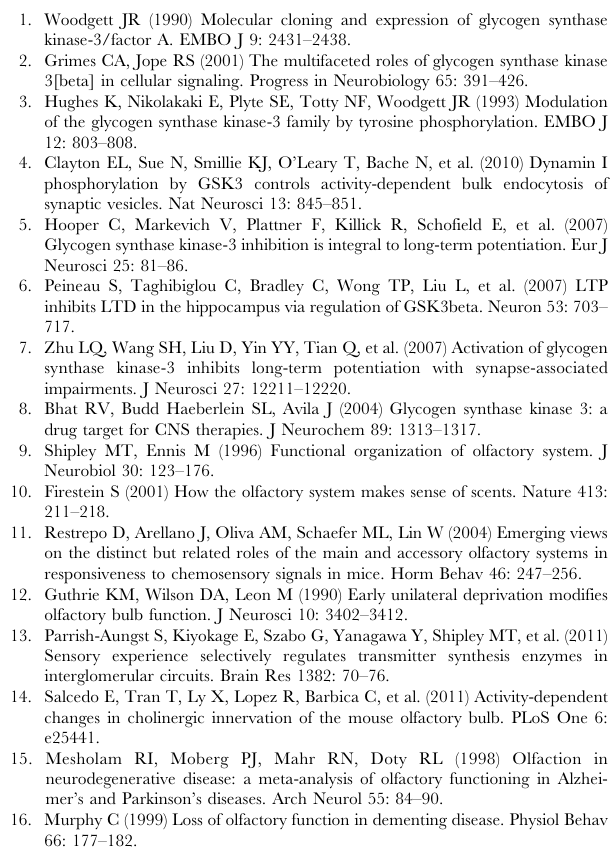
month. * P , 0.05, ** P , 0.01, *** P , 0.001. Not significant (N.S.). Data are shown as the mean 6 SEM. (TIF) Figure S4 Filtered electrophysiology signals of different frequency bands from the vehicle- and TDZD- treatment mice. Signals in all bands in the granular cell layer are decreased after TDZD-8 treatment. Theta, 1–12 Hz; Beta, 12–35 Hz; low- Gamma, 35–60 Hz; and high-Gamma, 60–90 Hz. (TIF) Figure S5 Electrophysiological recordings of the spon- taneous oscillatory activity two hours post vehicle- and TDZD-8-treatement in the OB. The relative powers are not significantly different in the pre- and post-vehicle treated mice (A, n =10, P= 0.245), but significantly different between pre- and post- TDZD-8 mice (B, n =10, P , 0.001). Not significant (n.s.). *** P , 0.001. The group data shown are the average 6 SEM.